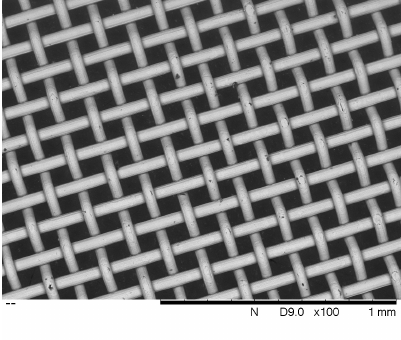
Figure 1. Scanning electron micrograph at × 100 magnification of 180 threads-per-inch 316-grade stainless steel woven mesh. Wire diameter: 50µm; Membrane thickness: 100µm to